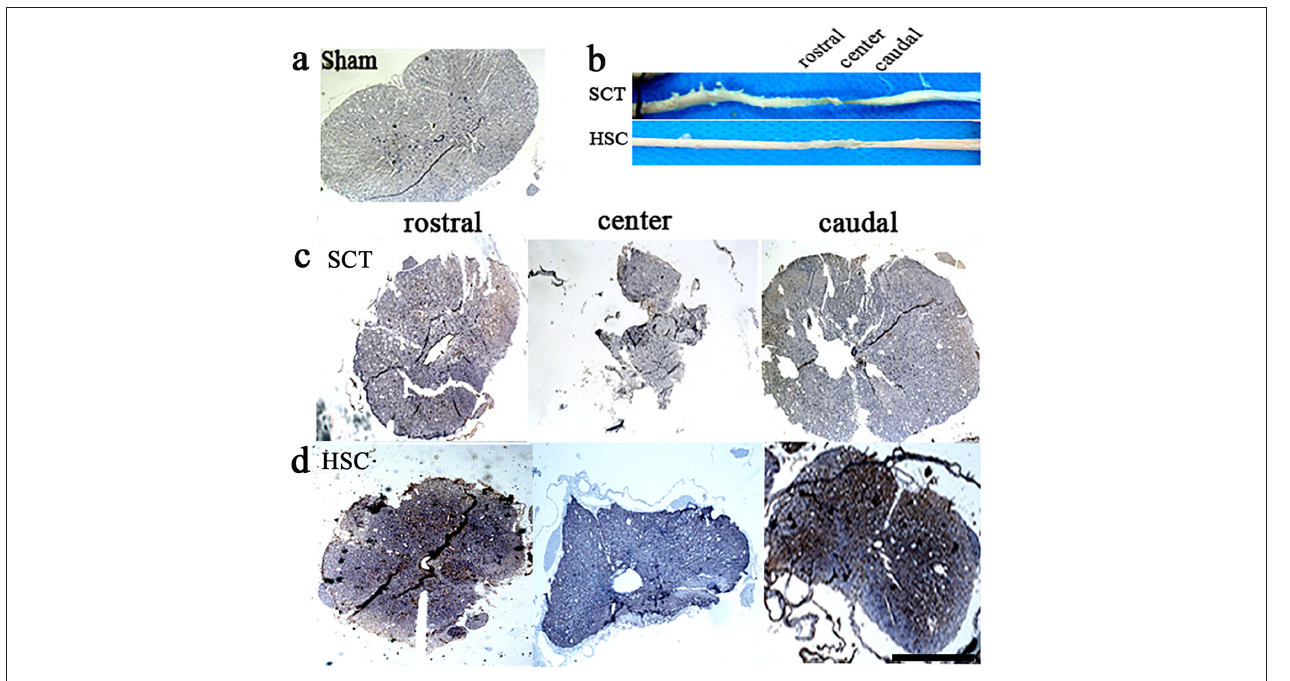
FIGURE 6 | HSC transplantation restored the volume of spared spinal cord. After SCT, compared with the sham one (A) , both rostral and caudal spinal cord exhibited a narrow shape, structure was damaged. Moreover, the volume in injured center decreased apparently with the narrowest shape (B) upper, (C) . Comparatively, HSC transplantation resulted in a significant increase on the volume of spared spinal cord (B) down, (D) . Bar = 200 µ m.